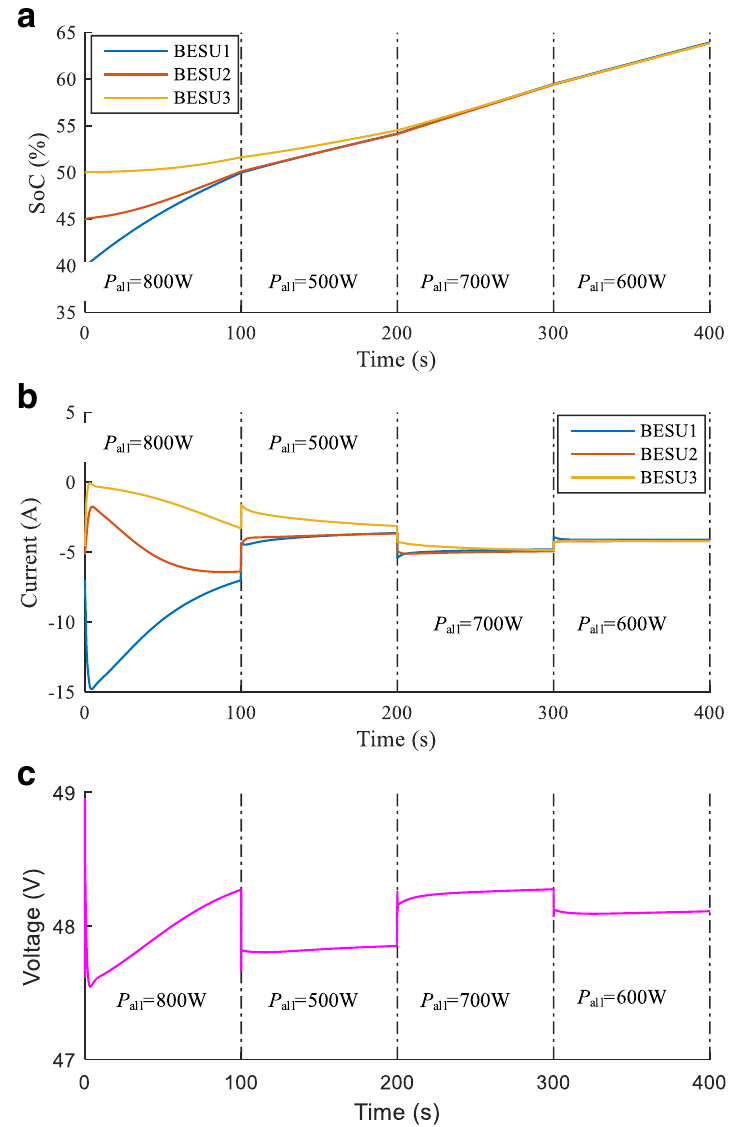
Fig. 6 Simulation results in charging